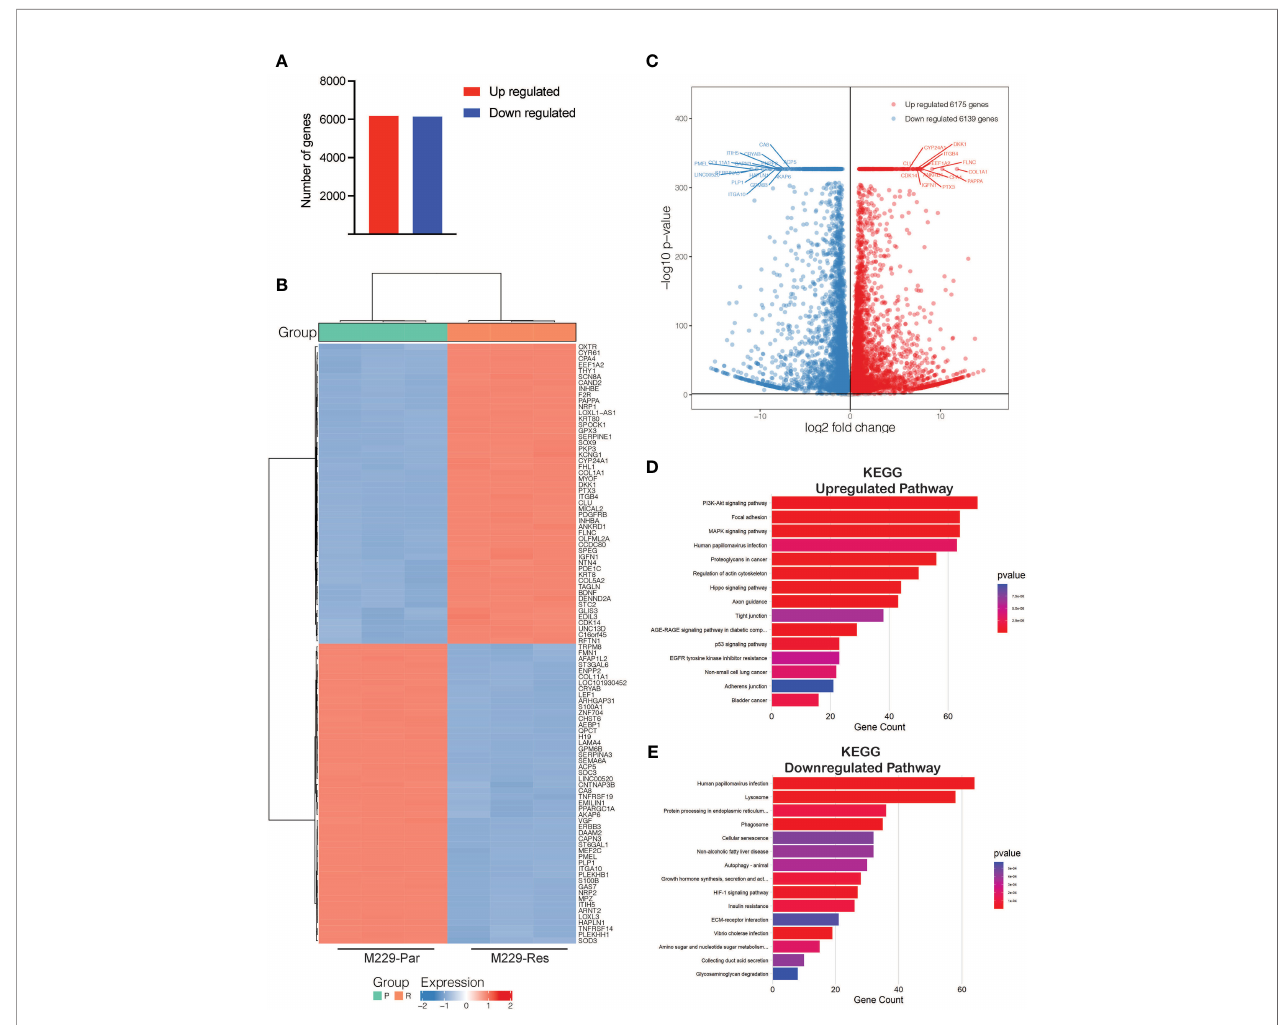
FIGURE 2 | RNA-sequencing identi fi ed differentially expressed mRNAs between M229-Par and M229-Res cells. (A) Total number of upregulated or downregulated genes with adjusted p -values ≤ 0.05 in M229-Res compared with M229-Par samples. (B) Heat map showing differentially expressed genes (up- or downregulated) in the indicated comparisons. The top 50 upregulated and the top 50 downregulated genes based on p-values are shown. (C) Volcano plot showing differentially expressed genes (up- or downregulated) in the indicated comparisons. The top 15 upregulated and the top 15 downregulated genes based on p-values are also labeled. (D, E) KEGG pathway analysis showing key upregulated (D) and downregulated (E) biological pathways associated with differentially expressed mRNAs in M229-Res cells compared with M229-Par